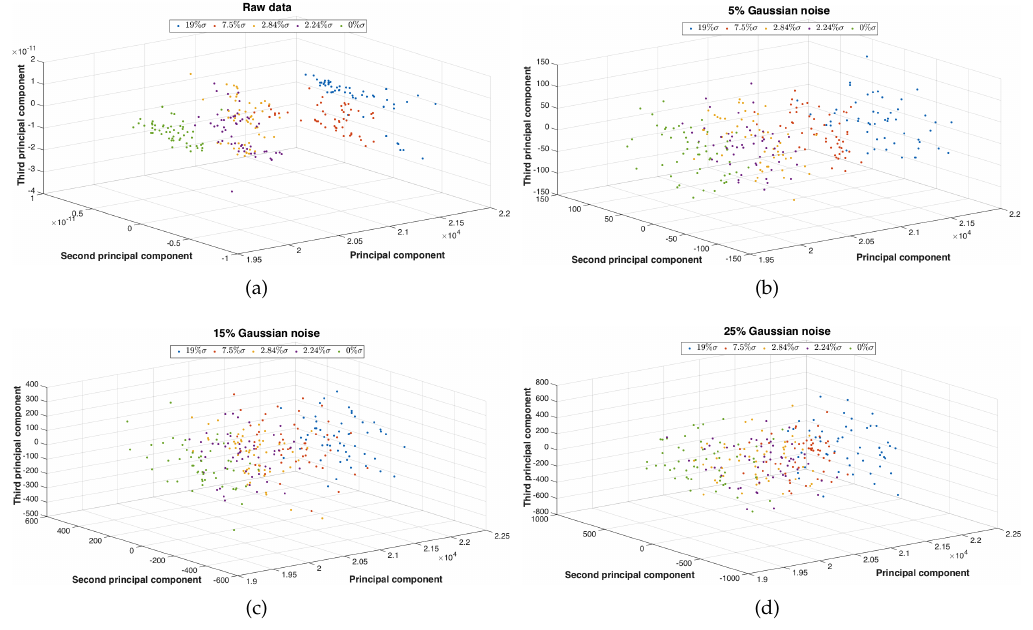
Figure 5. Distribution of the three main components of the induced magnetic field data for 0%, 2.24%, 2.84%, 7.7% and 19% of sigma ( σ ) phase: ( a ) raw data, and after the addition of ( b ) 5%; ( c ) 15%; and ( d ) 25% of Gaussian